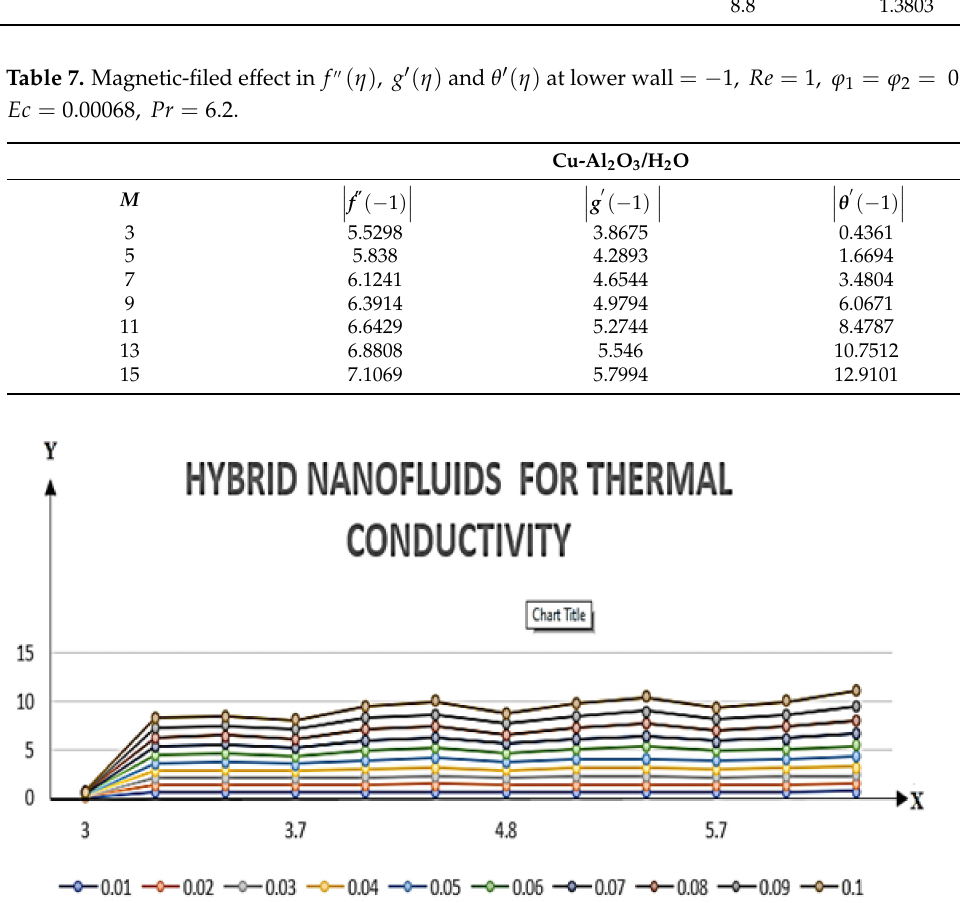
Figure 2. The influence of the scale of hybrid NPs under the thermal conductivity coloring umbrella. Reprinted from